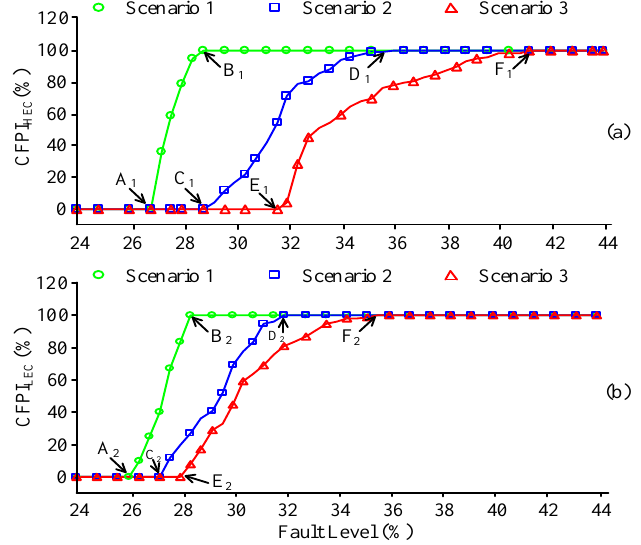
Figure 9. CFPI HEC and CFPI LEC values for three scenarios under three phase fault conditions